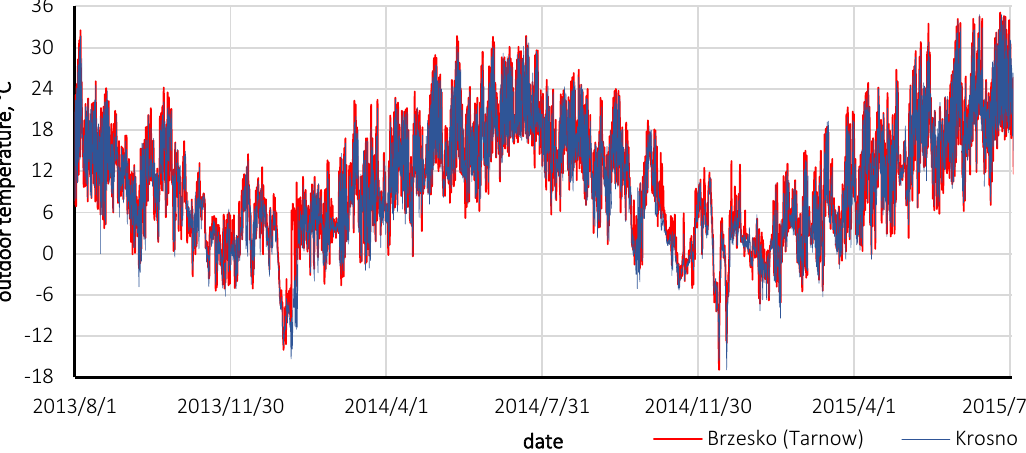
Figure 8. The comparison of hourly outdoor temperature ( T a ) taken from Tarnów and Krosno weather stations. Source: own study based on Reference [49].